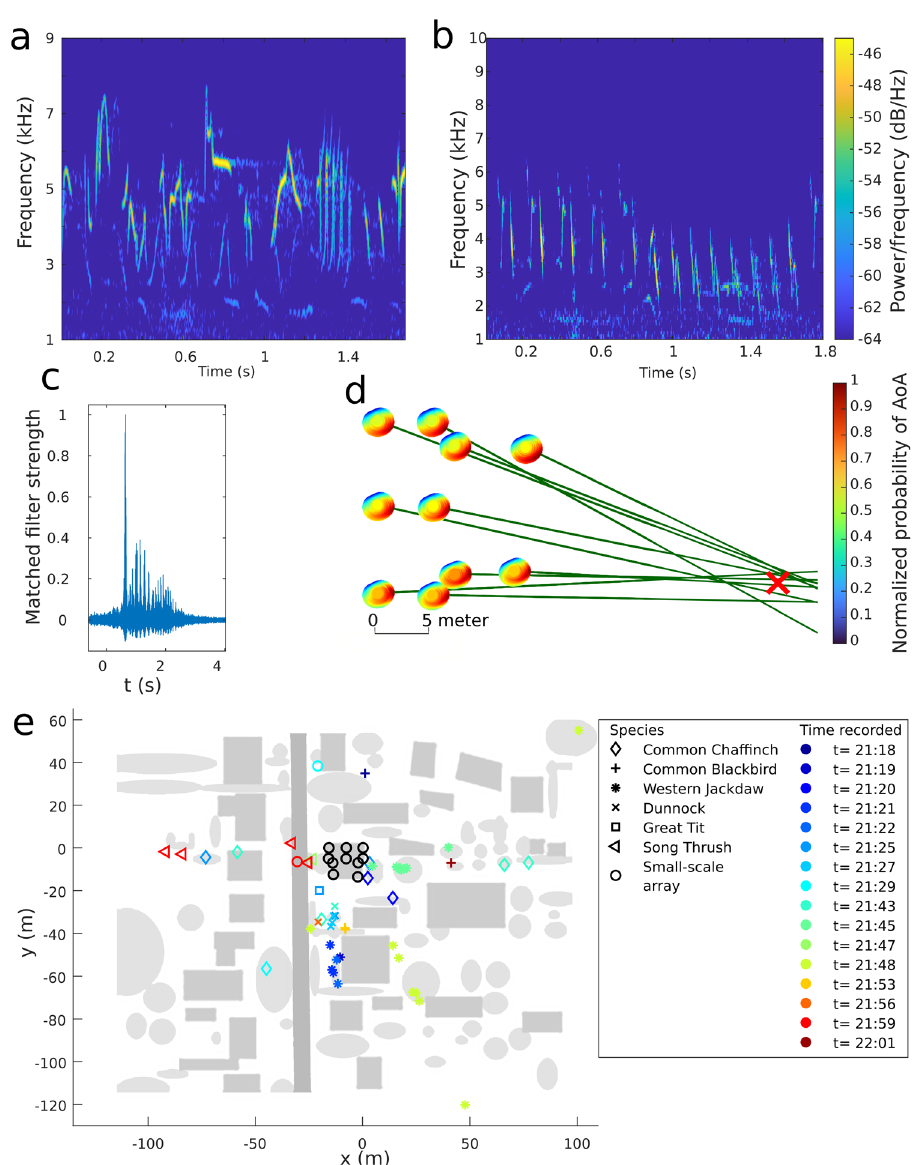
Fig. 4 Bird localization experiment using an array of ten small-scale arrays. a , b The spectrogram of a single dunnock song and a single common chaf fi nch song. The different syllables of the call can be seen clearly in the spectrogram. c Matched fi lter output for a single bird song. The matched fi lter fi nds the timing offset of a signal embedded in another signal. The peak value can be used to compare arrival time differences between acoustic channels. d Top view of the 3D localization of a single call. A probabilistic representation of the AoA is shown in a color-gradated hemisphere around each of the devices. The most probable direction of sound is shown in red. The convergence point of all AoA ’ s indicates the most probable bird location. e Overview of the observed area with the localized birds. The road is indicated in a dark gray, buildings and structures are indicated in a lighter gray, trees and hedges in the lightest gray and the bird locations in a color gradation indicating recording time. The scale goes from blue 21h18, beginning of the recording period, to red 22h01 end of the recording period. The ten small-scale arrays that have been placed on the roof of a building in the center are indicated by black circles. The ten small-scale arrays are spread over an area of ~18 m by 17 m. The relative positions of the small-scale arrays were measured manually during the construction of the array. In post-processing an aerial image of the neighborhood was positioned to match the small-scale array locations on the roof. The same image was used to draw in trees, hedges, buildings, and a